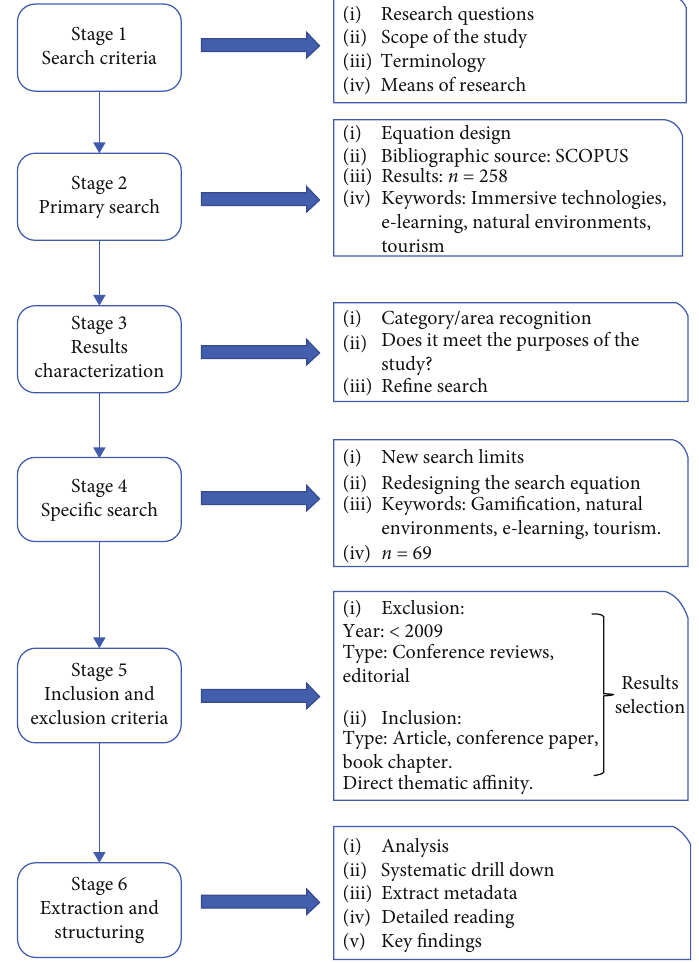
Figure 1: Methodology developed for the